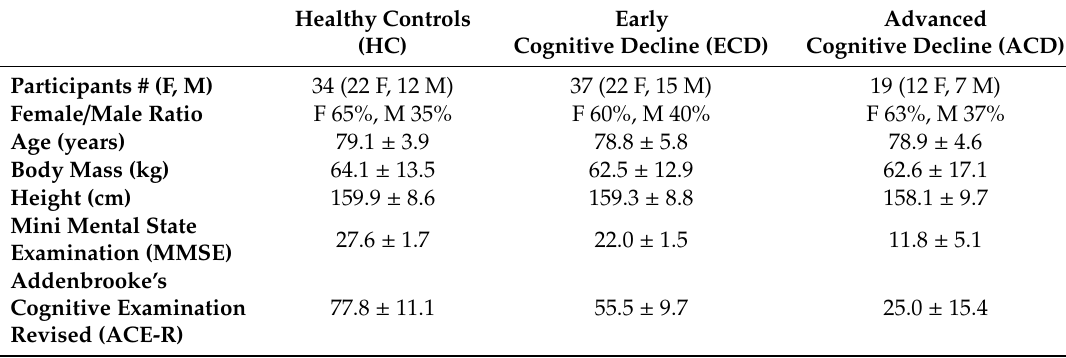
Table 1. Anthropometric and clinical features of participants. Values are expressed as mean ± SD. Healthy Controls Early (HC) Cognitive Decline (ECD)